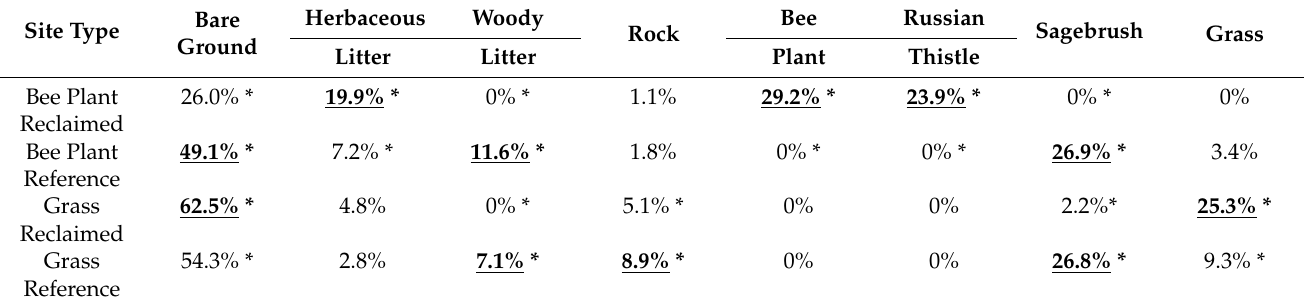
Table 2. Relative mean percent cover of sample point analysis in 2016. All sites had a total of 2880 secondary sampling units (pixels) analyzed, which are converted to percentages in this table. Reclaimed sites were compared directly to their paired adjacent reference sites. All sites were significantly different ( p < 0.001). Columns with * indicate those which were responsible for significant differences. Bolded and underlined numbers suggest higher proportion of that cover type within that site type compared to the paired reclamation or reference